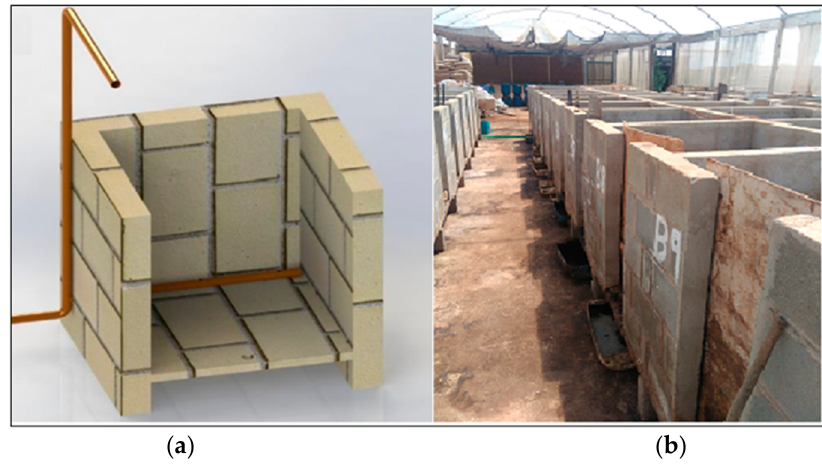
Figure 1. Graphic representation (a) and real image (b) of masonry structures used for vermicompostingin this study. Reference: Passos [16].